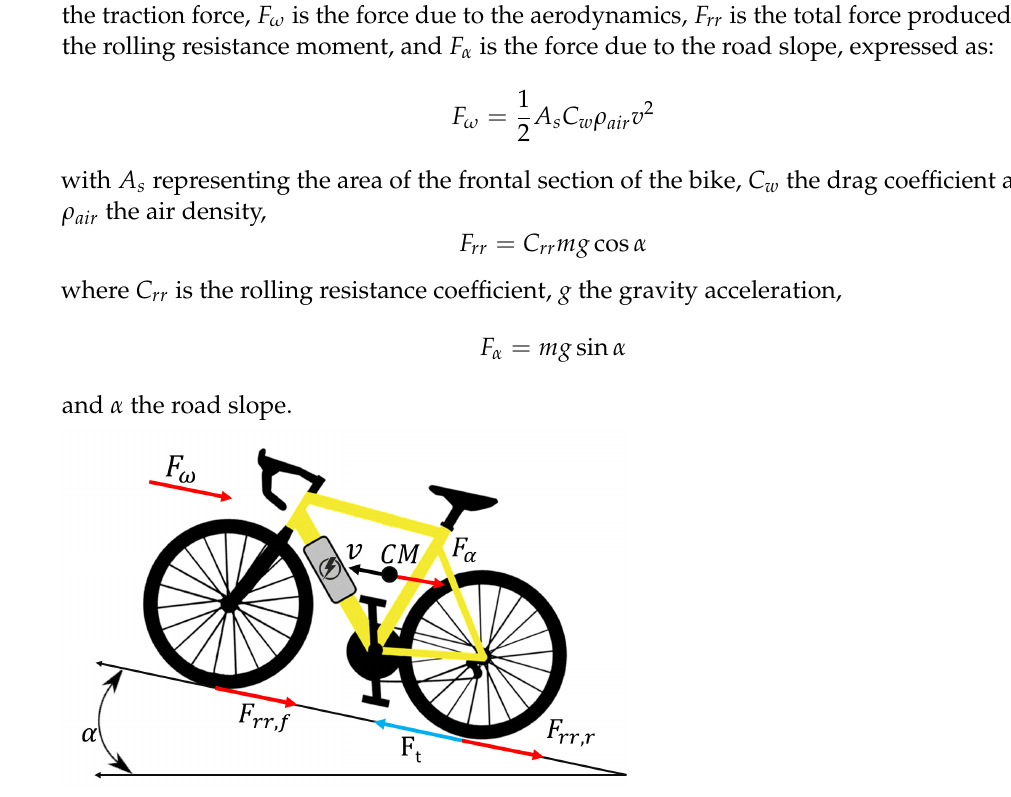
Figure 2. Bike free body